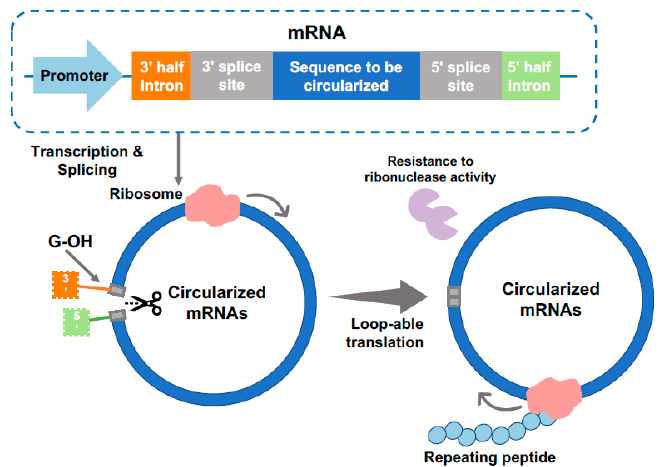
Figure 2. Synthesis of circular mRNA and its translation into repetitive proteins. Circular mRNA can be prepared using td intron. Td intron is a self-splicing intron from the thymidylate synthase ( td ) gene of the T4 bacteriophage. Td intron was divided and relocated, which placed the 3 (cid:48) half intron and 3 (cid:48) splice site upstream and a 5 (cid:48) half intron and 5 (cid:48) splice site downstream of a targeted protein sequence. The splicing reaction is catalyzed by exogenous guanosine and forms a back-splice junction. During circularization, the 5 (cid:48) caps and 3 (cid:48) tails are removed, which prevents the binding of ribonuclease and initiates the loopable translation